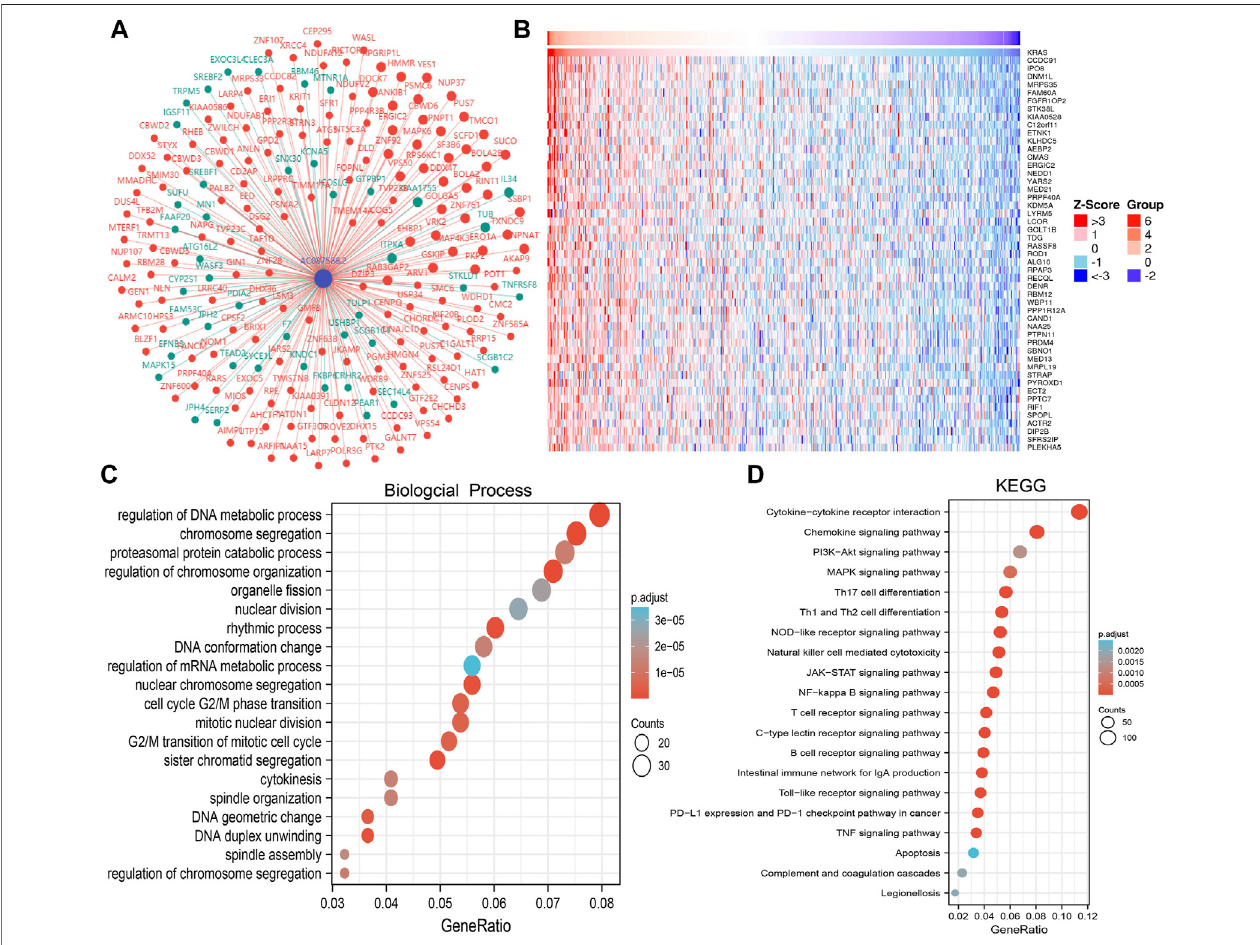
FIGURE 6 | KEGG enrichment analysis of AC087588.2. (A,B) Gene – gene interaction network of AC087588.2 in LUAD. (C,D) GO and KEGG enrichment analysis of AC087588.2 in LUAD.